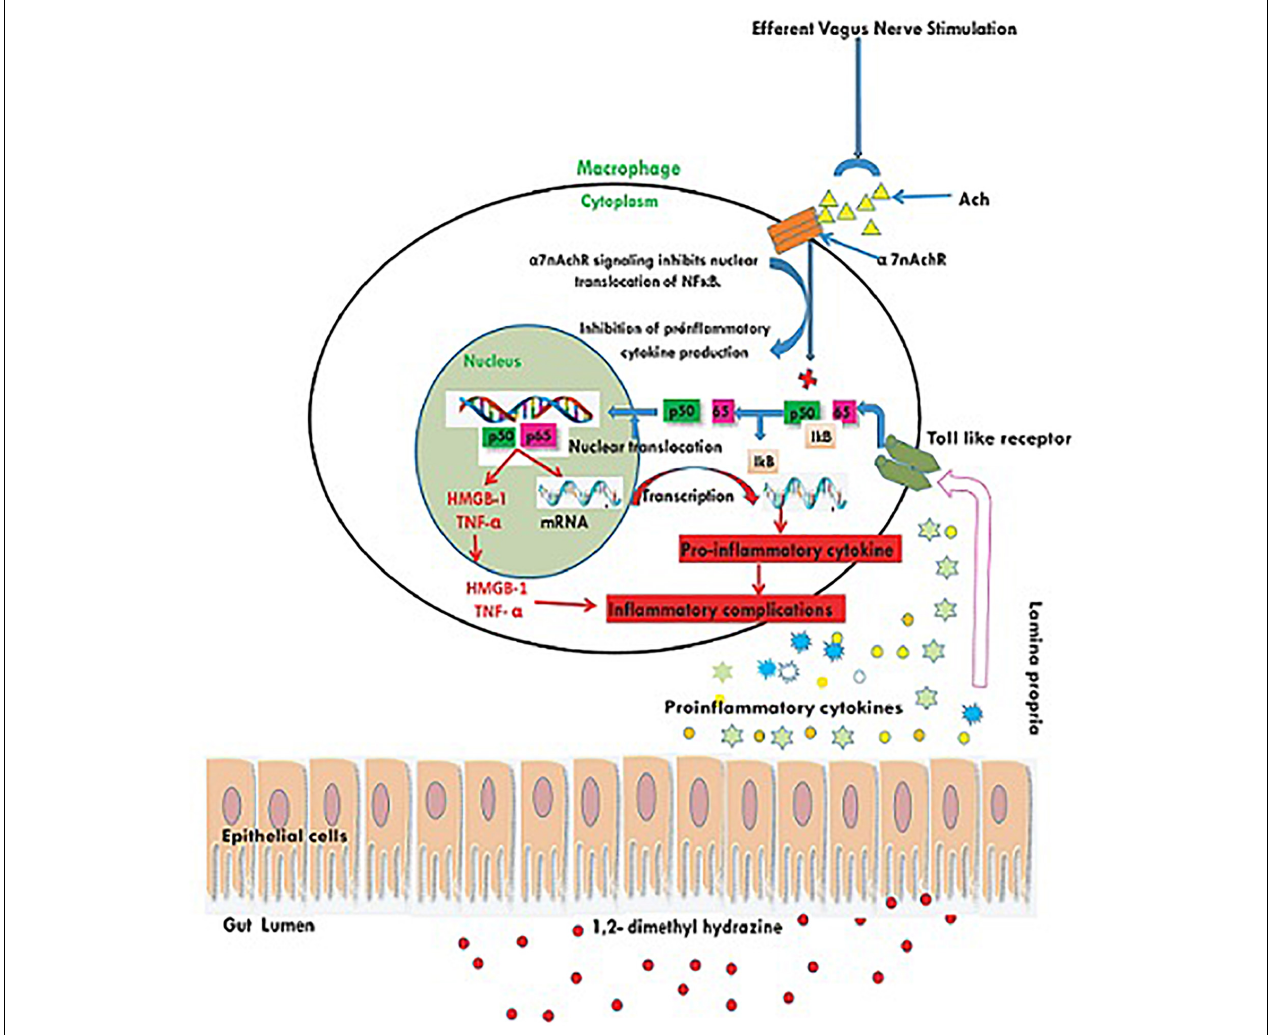
FIGURE 5 | Schematic representation for the effect of taVNS on CAP. Inflammatory/toxic substances invoke series of pro-inflammatory signals to bind with toll like receptors on the cellular membranes. Binding to the toll like receptors mediates the translocation of NF κ B to nucleus and release of pro-inflammatory mediators. taVNS can facilitate the Ach release to act upon the α 7nAchR receptor, which in turn inhibits the translocation of NF κ B to nucleus and therefore curtails the inflammatory